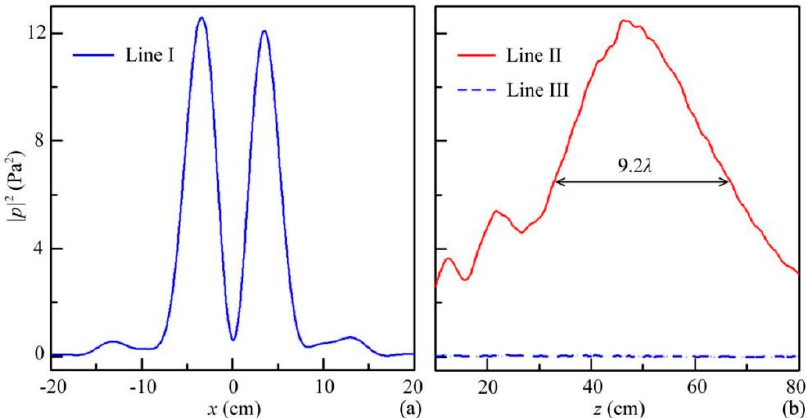
Figure 4. Simulated acoustic intensity distributions through the ABV beam along lines ( a ) I, ( b ) II, and III in Figure 3d.